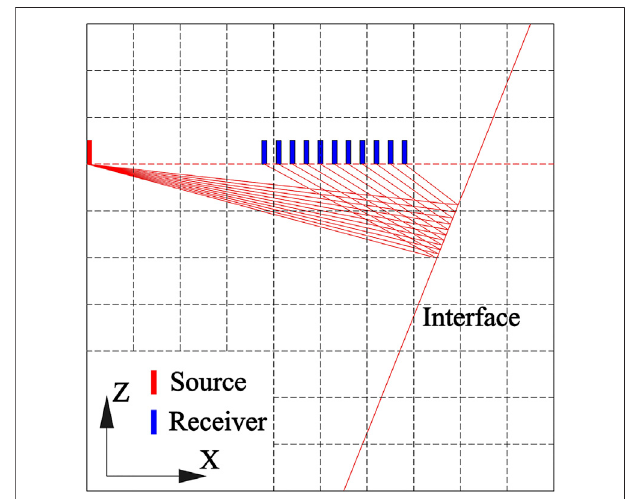
FIGURE 1 | Schematic of seismic wave re fl ection from slant interface in the advanced detetion model. Unlike ground seismic exploration, there are few source and receivers in tunnel seismic advanced detection. It is dif fi cult to stack in the common re fl ection